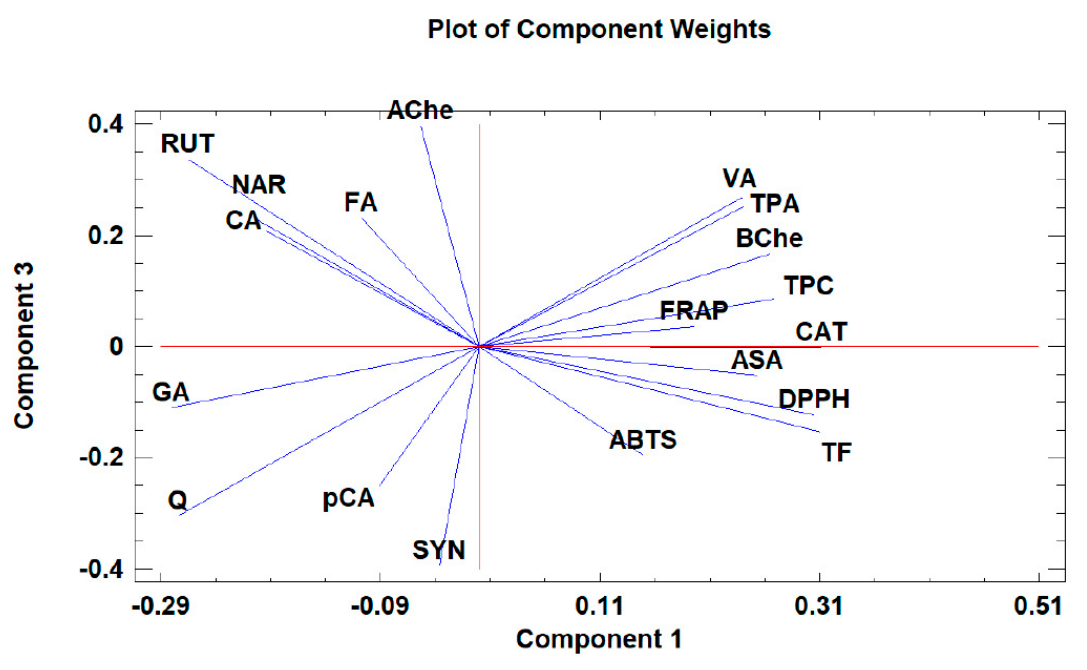
Figure 3. The loading plot of principal components 1 and 3 for the tested Withania somnifera samples extracted with two different protocols (hydromethanolic and aqueous extracts).